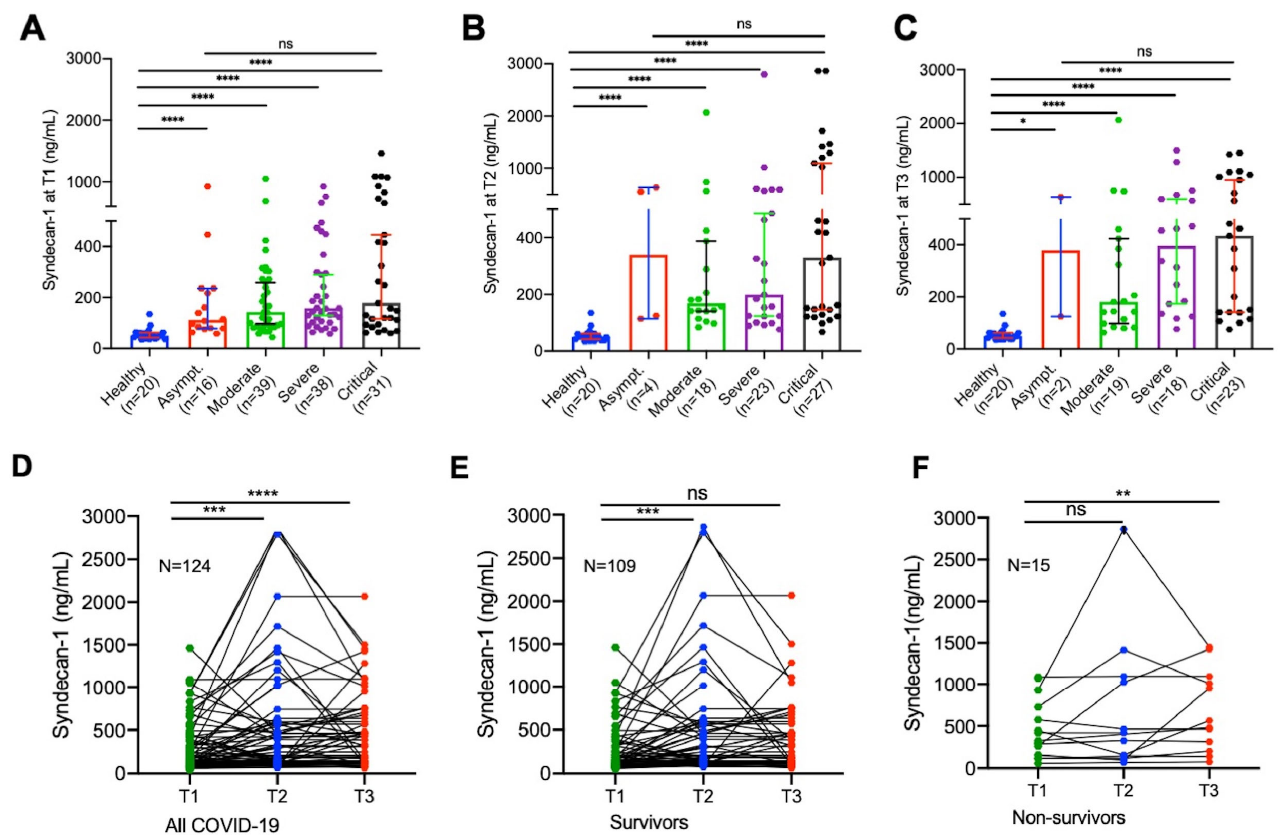
Figure 1. Plasma levels of syndecan-1 in hospitalized patients with SARS-CoV-2 infection and healthy controls. ( A – C ) Plasma levels of syndecan-1 in healthy controls ( n = 20), asymptomatic patients, patients with moderate, severe, and critical COVID-19 at T1, T2, and T3, respectively. The data shown are individual values, the median, and interquartile range (IQR). Kruskal–Wallis test was performed to determine the statistical significance among the groups. Here, n.s. and **** indicate a p value >0.05 and <0.0001, respectively. ( D – F ) Longitudinal changes of plasma levels of syndecan-1 at T1, T2, and T3 in all patients with SARS-CoV-2 infection ( n = 124), those who survived ( n = 109), and those who died ( n = 15) within 60 days of follow-up, respectively. Each individual value and trend at T1, T2, and T3 are shown. Paired t -test was performed to determine the statistical significance in plasma syndecan-1 levels of patients comparing each two groups. Here, n.s., *, **, ***, and **** indicate the p values of >0.05, <0.05, <0.01, <0.005, and <0.0001, respectively.